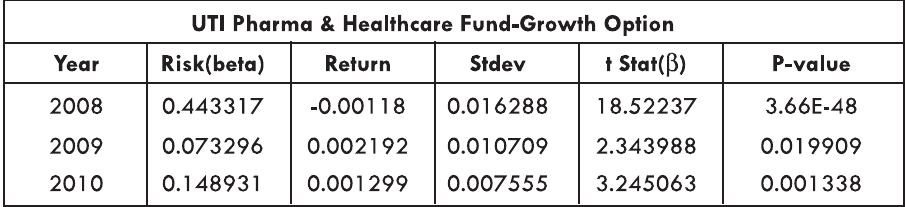
Table 4 : Risk and Returns of UTI Pharma & Healthcare Fund-Growth Option Scheme during the Study Period (2008 to 2010)